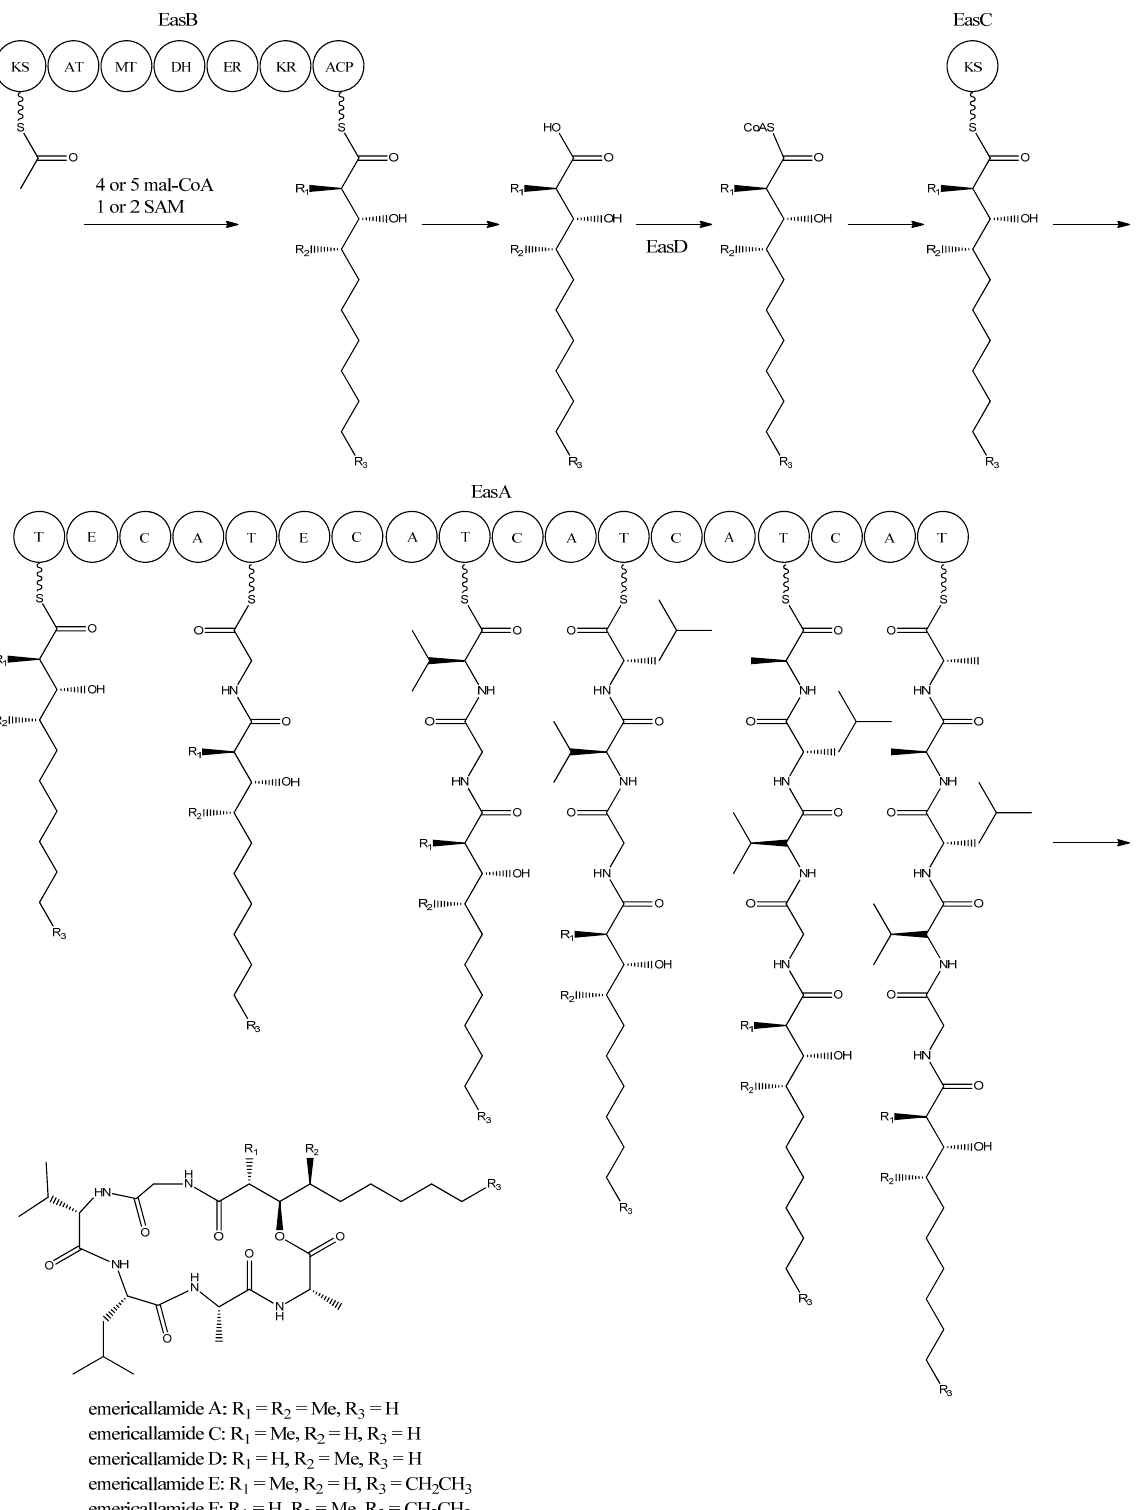
Figure 6. Proposed biosynthesis of the emericallamides. The order of the methyltransferase (MT) and dehydratase (DH) domain as suggested by Chiang et al. [69], however a BLASTp analysis suggests a swapping of the MT and DH domains. The NRPS, EasA, contains 18 (T, E (epimerization), C, A) domains grouped into five